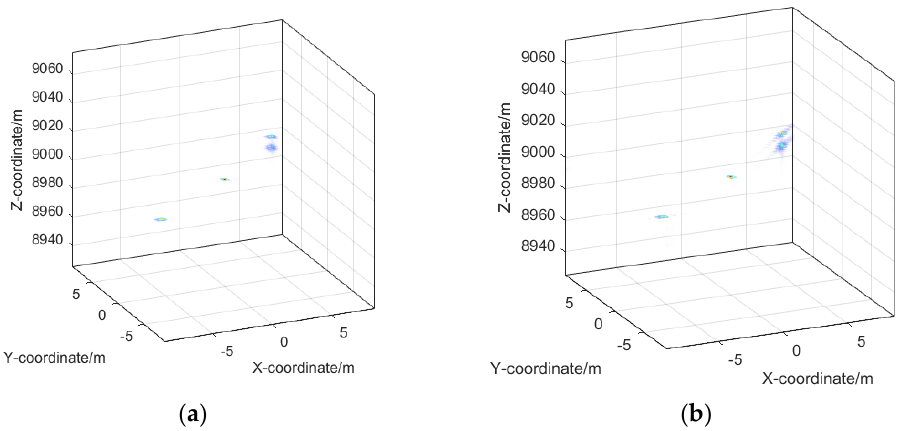
Figure 16. The final imaging results of the two algorithms. ( a ) Final imaging result of BP algorithm. ( b ) Final imaging result of OMP algorithm.